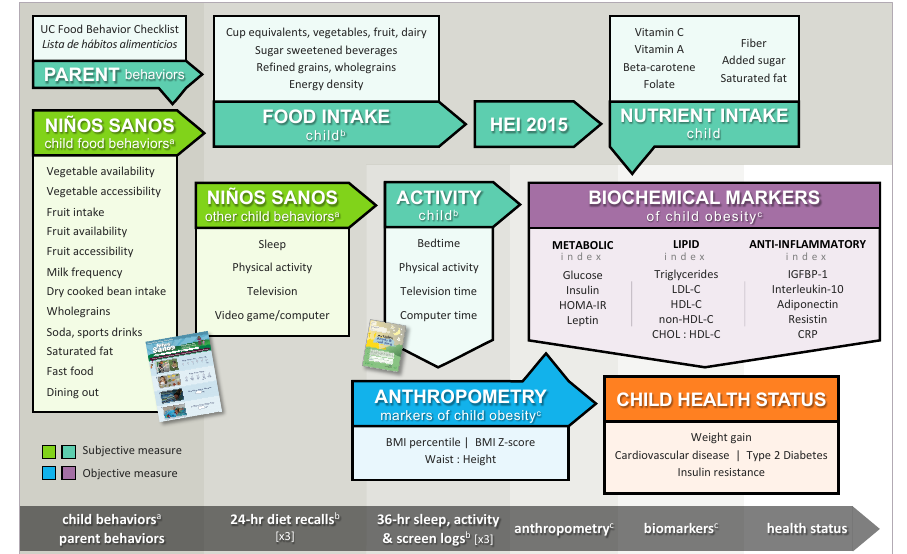
Figure 1. Biopsychosocial framework for validation of Niños Sanos targeting migrant families with preschool-aged children